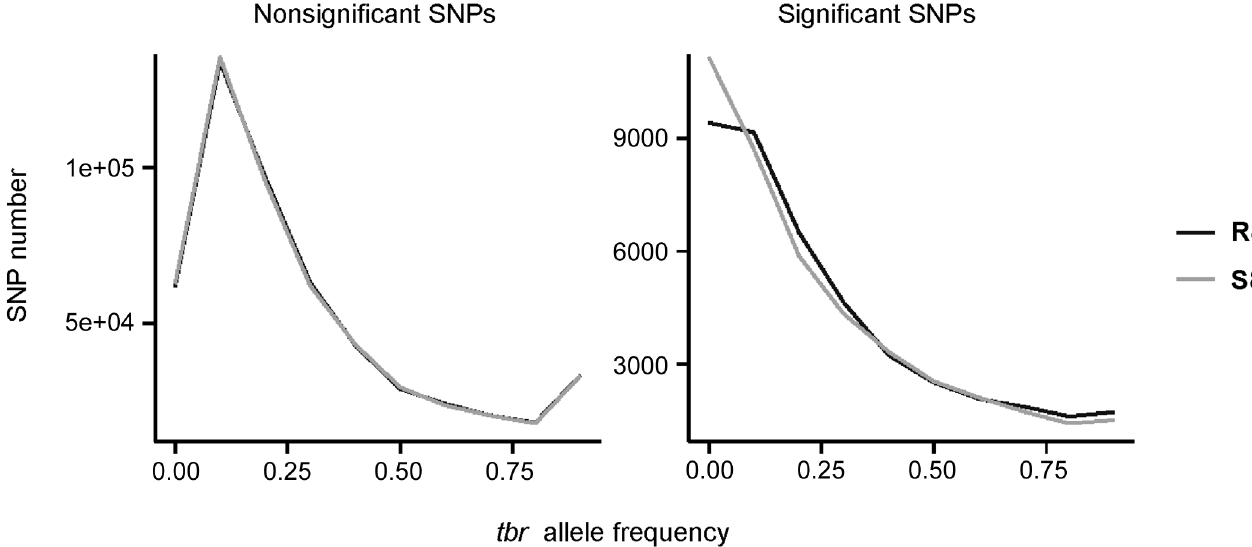
Fig 4. Frequency distribution of the tbr ( S . tuberosum ) SNP alleles with different allele frequencies (q < 0.01) in the R8 and S8 genotype pools (significant SNPs) and without significant differences (q > 0.01, non-significant